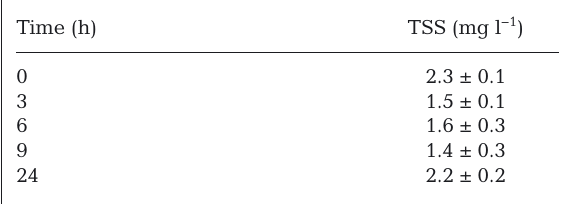
detection limit (<0.01 mg l −1 ; data not shown). Measure - ment of oxygen concentration in sealed glass bottles (see ‘Materials and methods’) revealed a complete de- pletion of oxygen from 5.28 to 0 mg l −1 within 45 min (data not shown), confirming anaerobic conditions.